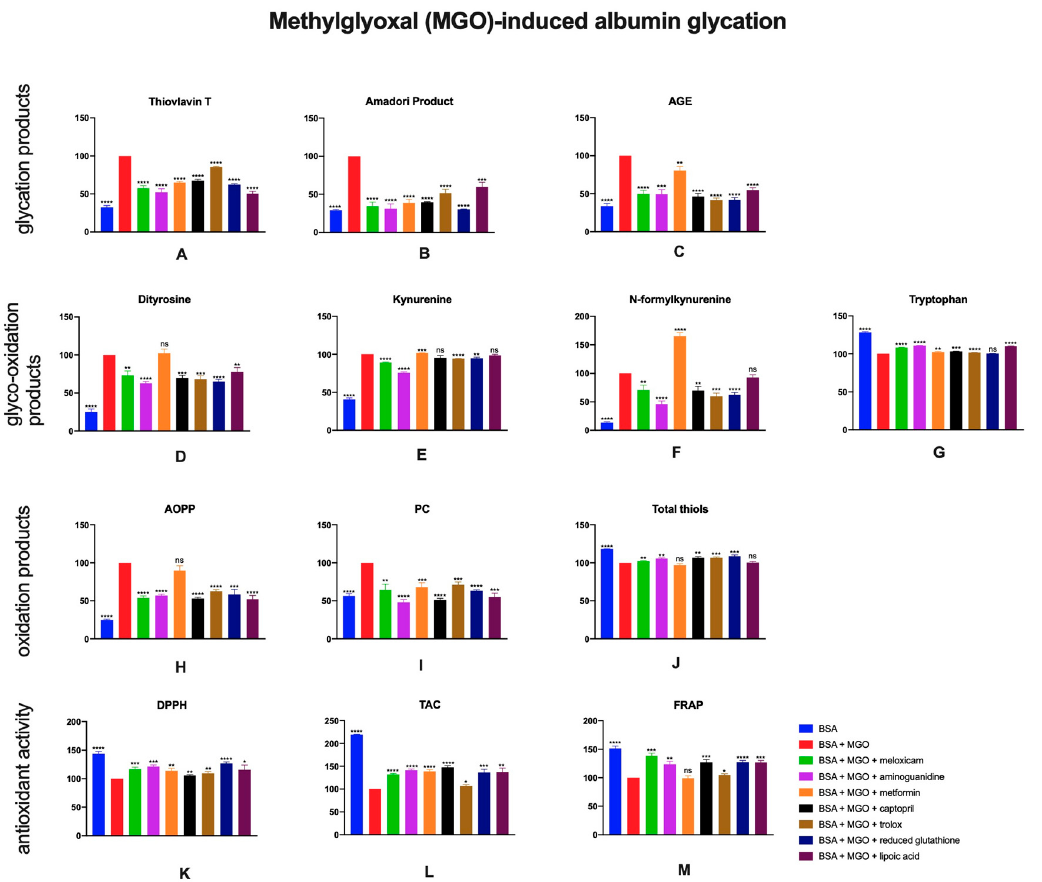
ff ects of meloxicam, captopril, trolox, reduced glutathione, lipoic acid, Figure 6. The effects of meloxicam, captopril, trolox, reduced glutathione, lipoic acid, aminoguanidine Figure 6. The e